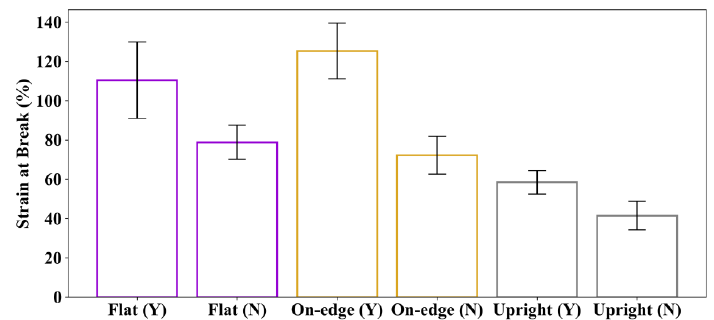
Figure 12. Comparison of the average maximum tensile strength. ”Y” indicates specimens with post- processing, and ”N” means specimens without post-processing.